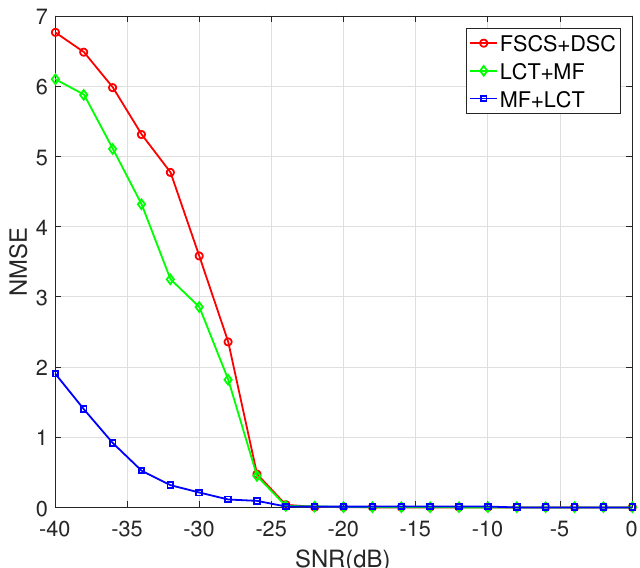
Figure 18. Speed estimation performance with different